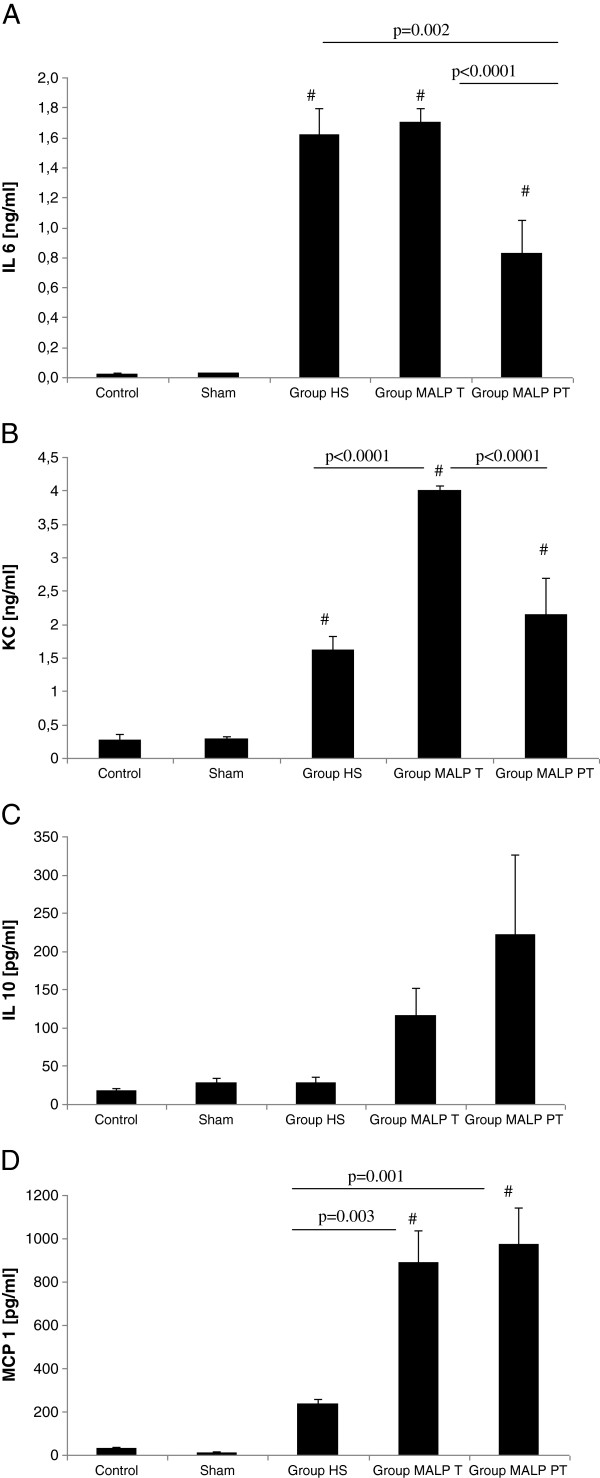
Comparison of plasma IL-6 (A), KC (B), IL-10 (C), and MCP-1 (D) levels in C57/BL6 mice; Animals were subjected either to MALP-2 pre-treatment (12 hours) (Group MALP PT) or MALP-2 was administered following HS (90 minutes) (Group MALP T).Group HS: hemorrhagic shock with PBS administration after 90 minutes. Results are expressed as means ± SE of 6 animals per group (#<0.05 vs. Control/Sham).